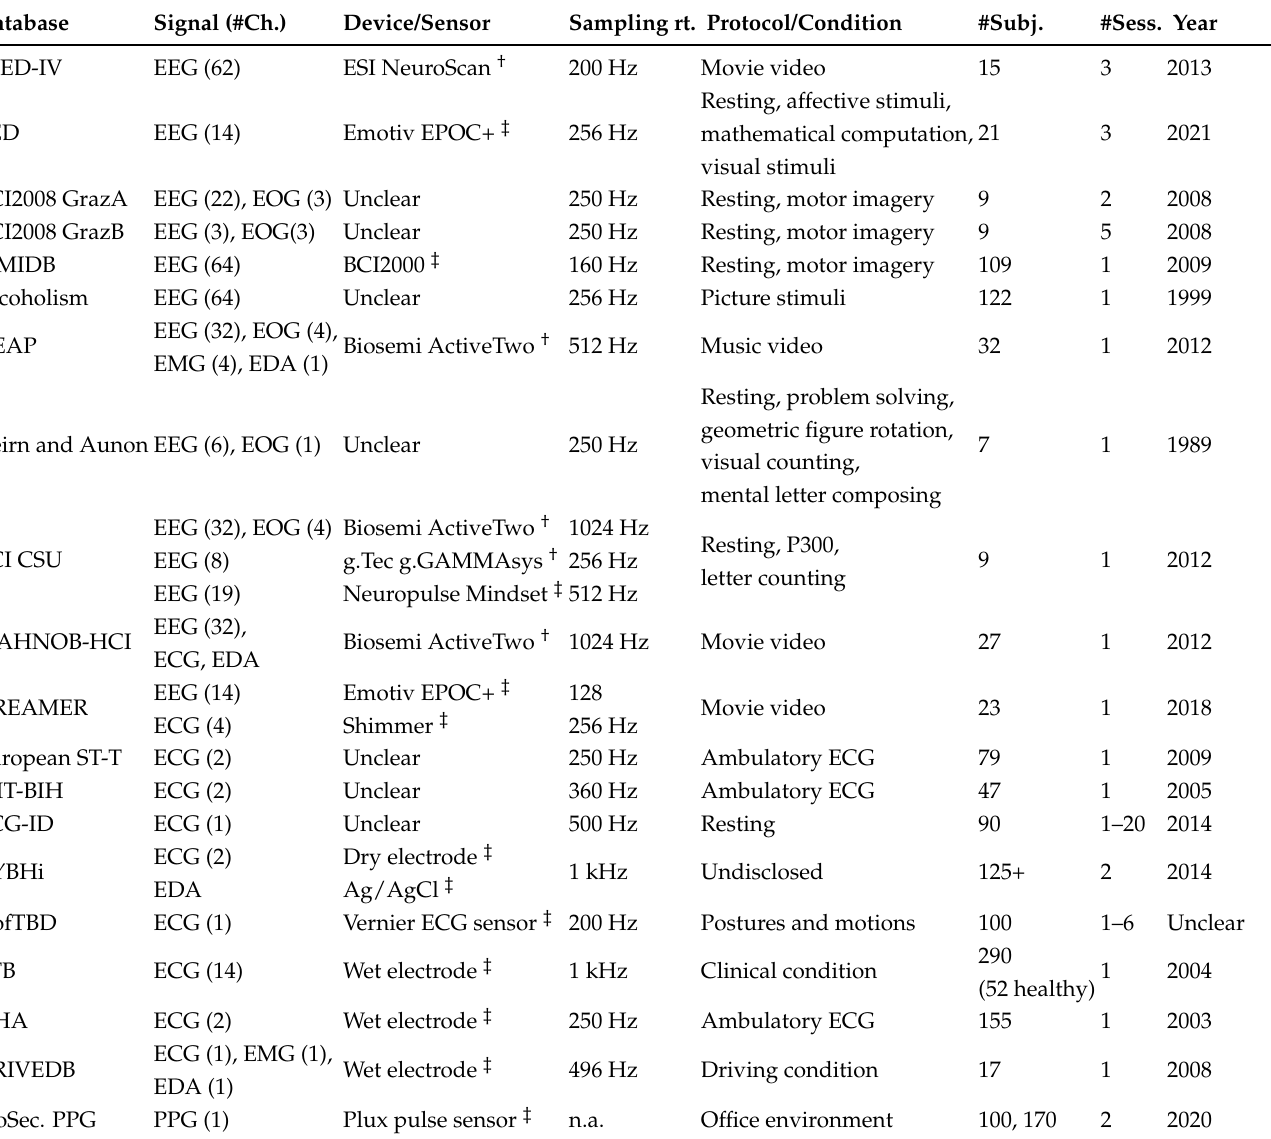
Table 2. Public databases for cognitive